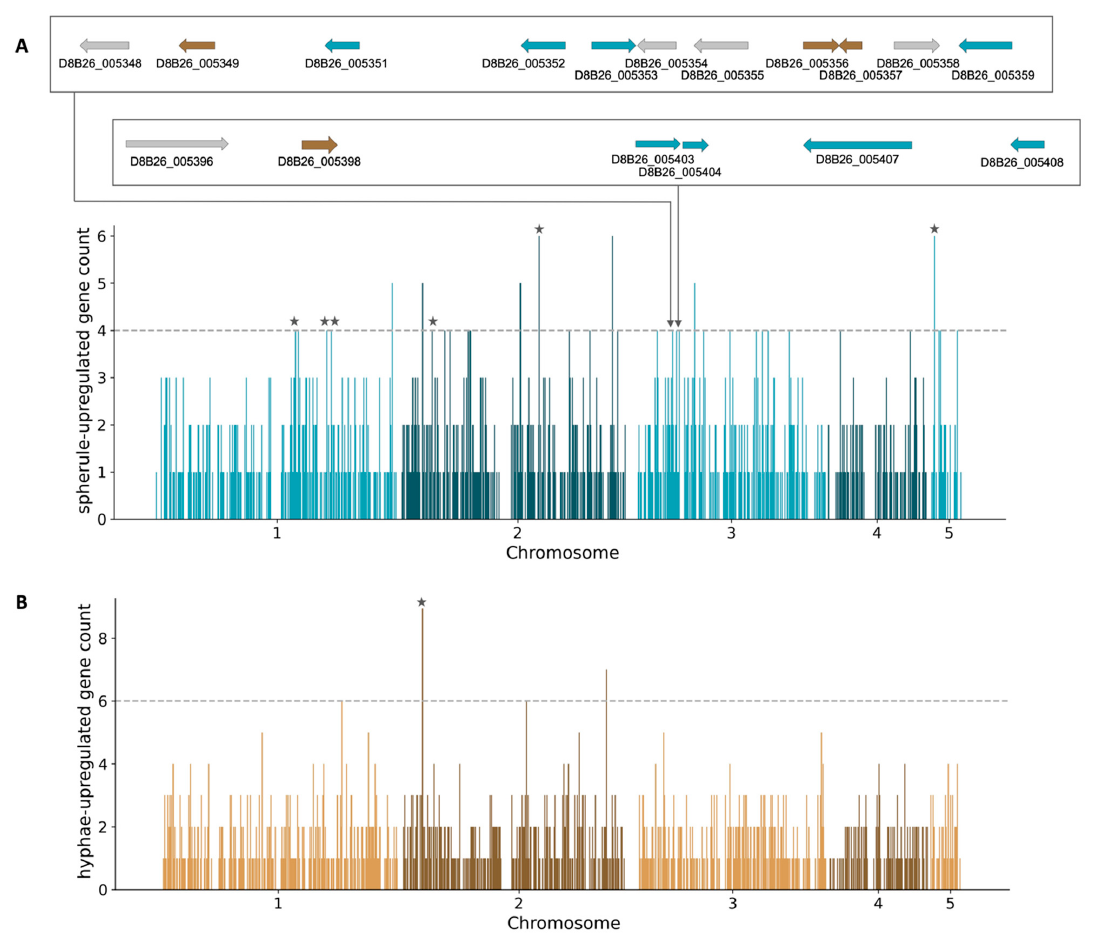
Figure 2. Spherule-gene and hyphae-gene islands. Each panel reports the results of a test for geno- mic regions over-represented among genes induced in one C. posadasii life cycle phase. The x-axis reports the chromosome positions of a given genomic window, and the y-axis reports the number of genes in the window upregulated in spherules ( A ) or hyphae ( B ). The dashed line reports the maximum number of genes of the respective induction behavior expected in a window under a null model. Stars indicate windows overlapping with secondary metabolite clusters from Figure 1, and inset tracks indicate windows in a highly variable region of chromosome III (see below).